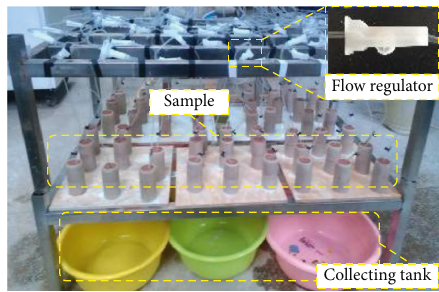
Figure 2: Simulation leaching.